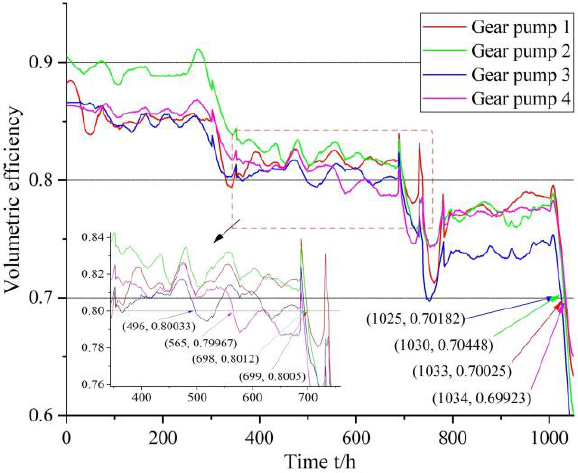
Figure 6. Volumetric efficiency degradation curves of gear pumps.